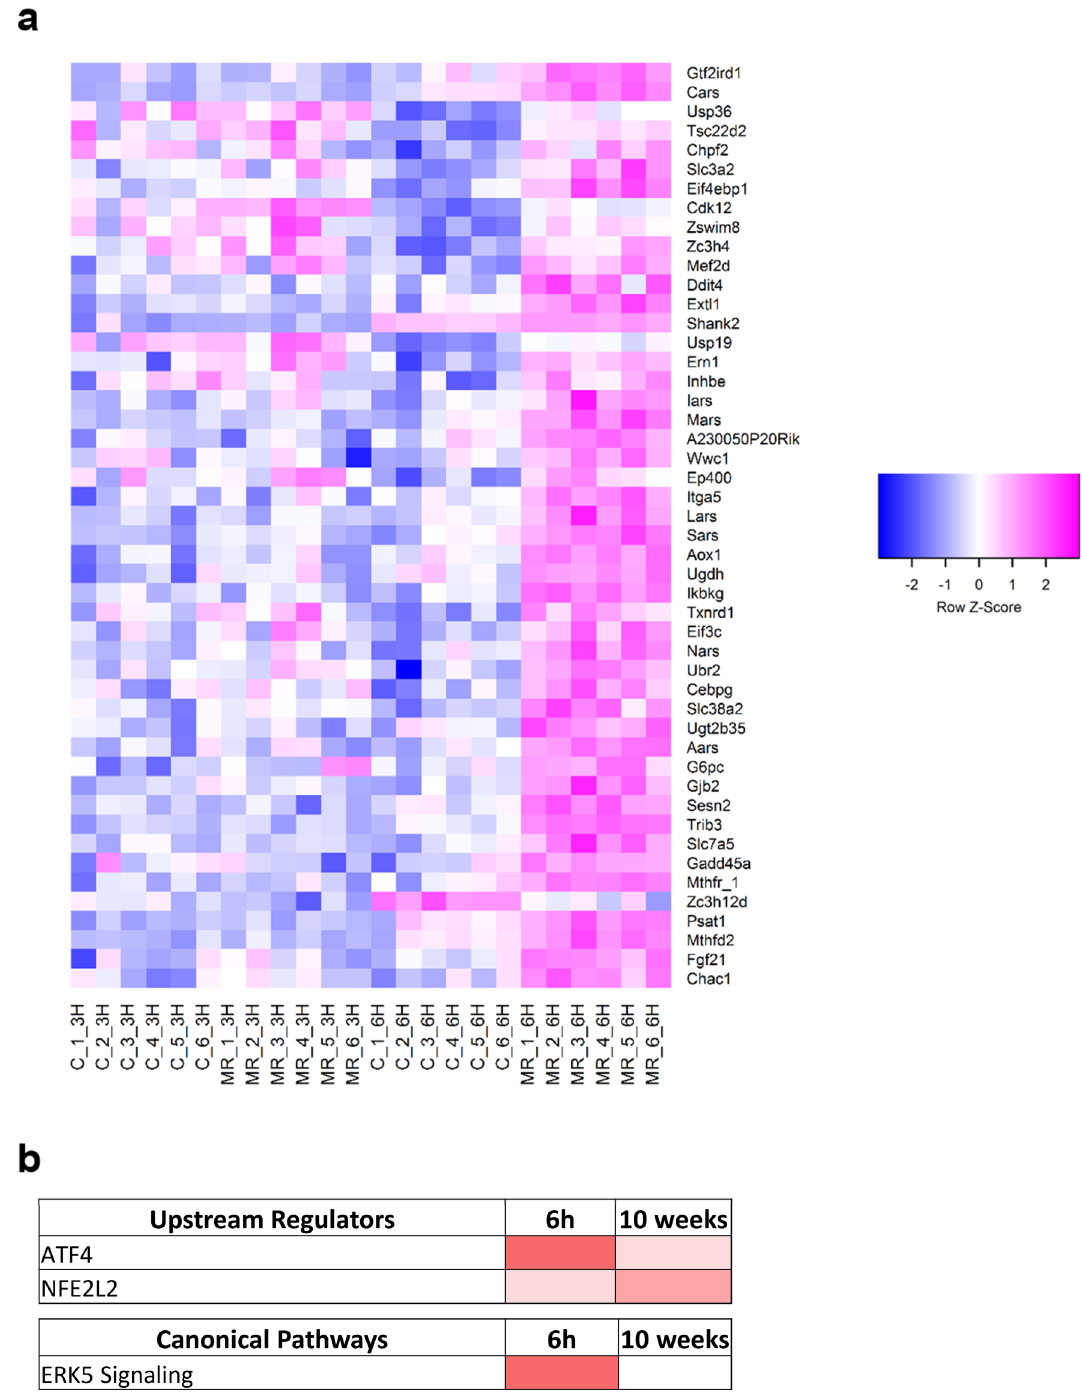
Figure 3. Heatmap of liver genes induced after 6 h on MR ( a ). Genes significantly different in MR versus Con at 6 h (FDR < = 0.001) are presented based on the magnitude of fold changes. The expression of these genes was measured using RNAseq and is shown for each of the 3 h and 6 h samples. Heatmaps were constructed via the gplots package in R (version 2.2.0, https ://cran.r-proje ct.org/web/packa ges/gplot s/index .html) ( b ) Comparison of liver samples from mice fed Con or MR for either 6 h or 10 weeks. Upstream regulators and canonical pathways were identified by IPA analysis and are shown according to z-scores (n = 6/group; activating in red). ( c ) Gene expression in mouse livers after either 6 h (upper panel) or 10 weeks (lower panel) on Con or MR was determined by qPCR (n = 8/group). ( d ) HepG2 cells were transfected with either scrambled or ATF4 siRNA and gene expression was measured after cultivation for 6 h in either Con or MR media. ( e ) HepG2 cells were treated with either vehicle (DMSO) or Torin (200 nM) and then exposed to either Con or MR media for 6 h. Data for HepG2 cells were obtained from at least two independent experiments with duplicates, and fold induction was averaged. Data were compared between Con and MR and between MR and MR with ATF4siRNA ( D ) or MR with Torin ( E ) for each gene using unpaired t-test and are presented as fold induction from Con. * Means annotated with an asterisk differ from Con at p < 0.05, while means differing between MR without and MR with ATF4siRNA ( D ) or Torin ( E ) at p < 0.05 are annotated with the pound symbol #